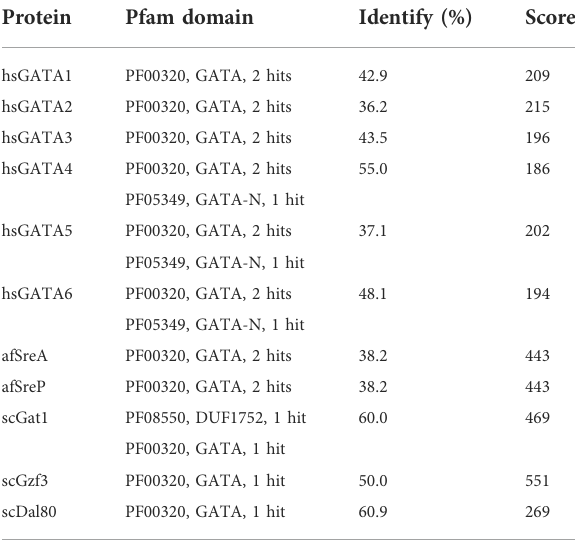
TABLE2Sequence comparisonofspFep1 toitssequencehomologsin A. fl avus , H. sapiens , and S. cerevisiae . Protein Pfam